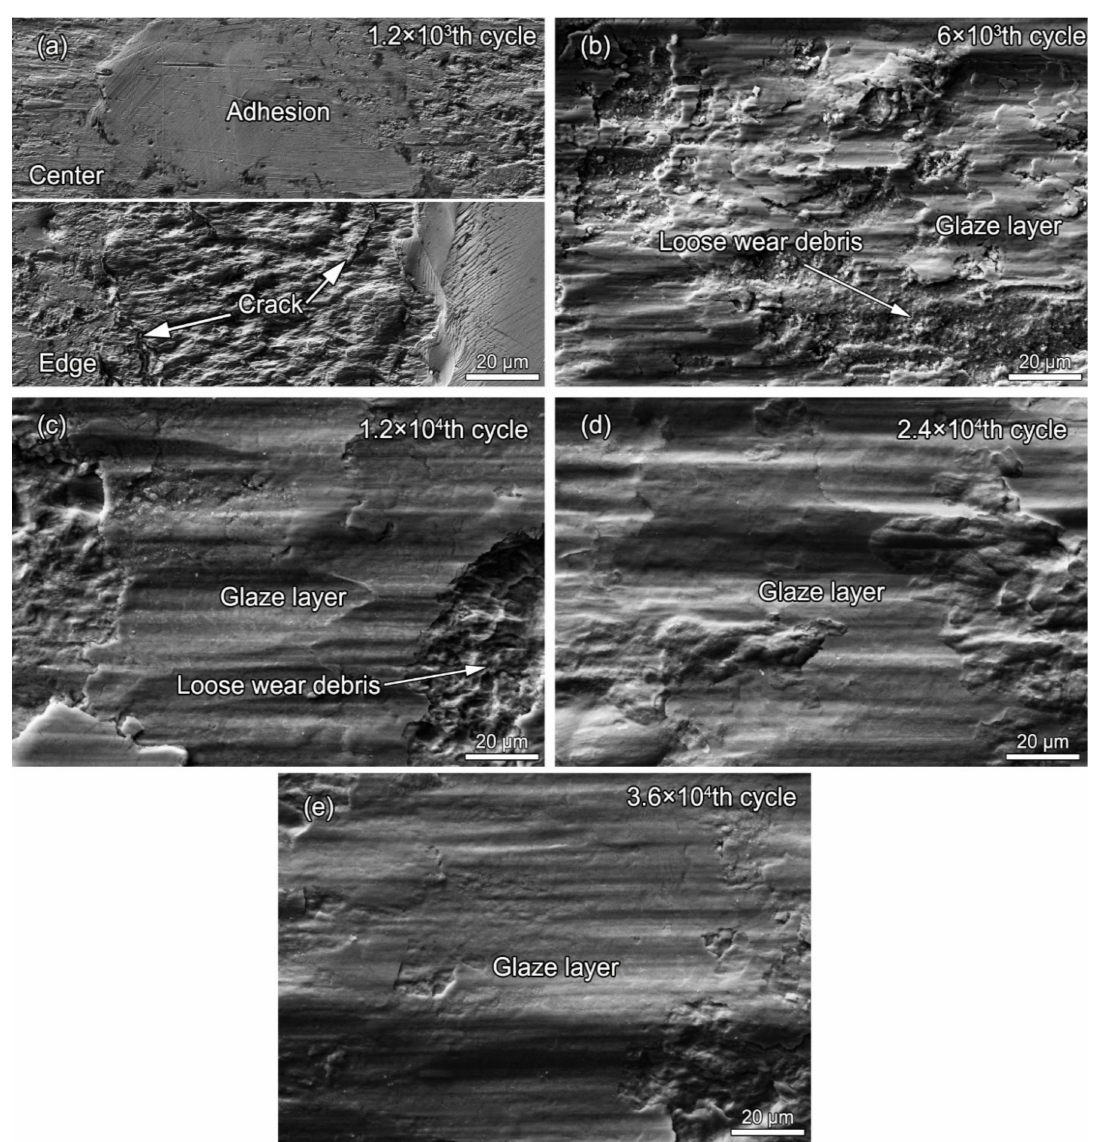
Figure 6. The detailed SEM surface morphologies of worn scars of alloy 690TT after fretting cycles of ( a ) 1.2 × 10 3 , ( b ) 6 × 10 3 , ( c ) 1.2 × 10 4 , ( d ) 2.4 × 10 4 , and ( e ) 3.6 × 10 4